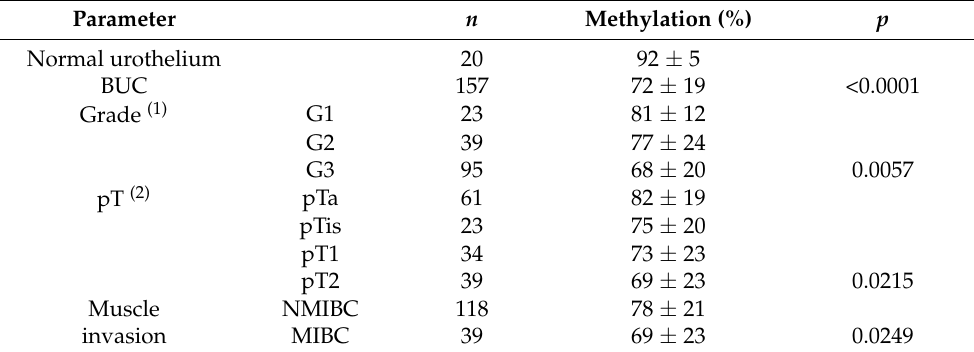
Table 1. Methylation levels of promoter CpG of CLDN4 gene in 157 BUC